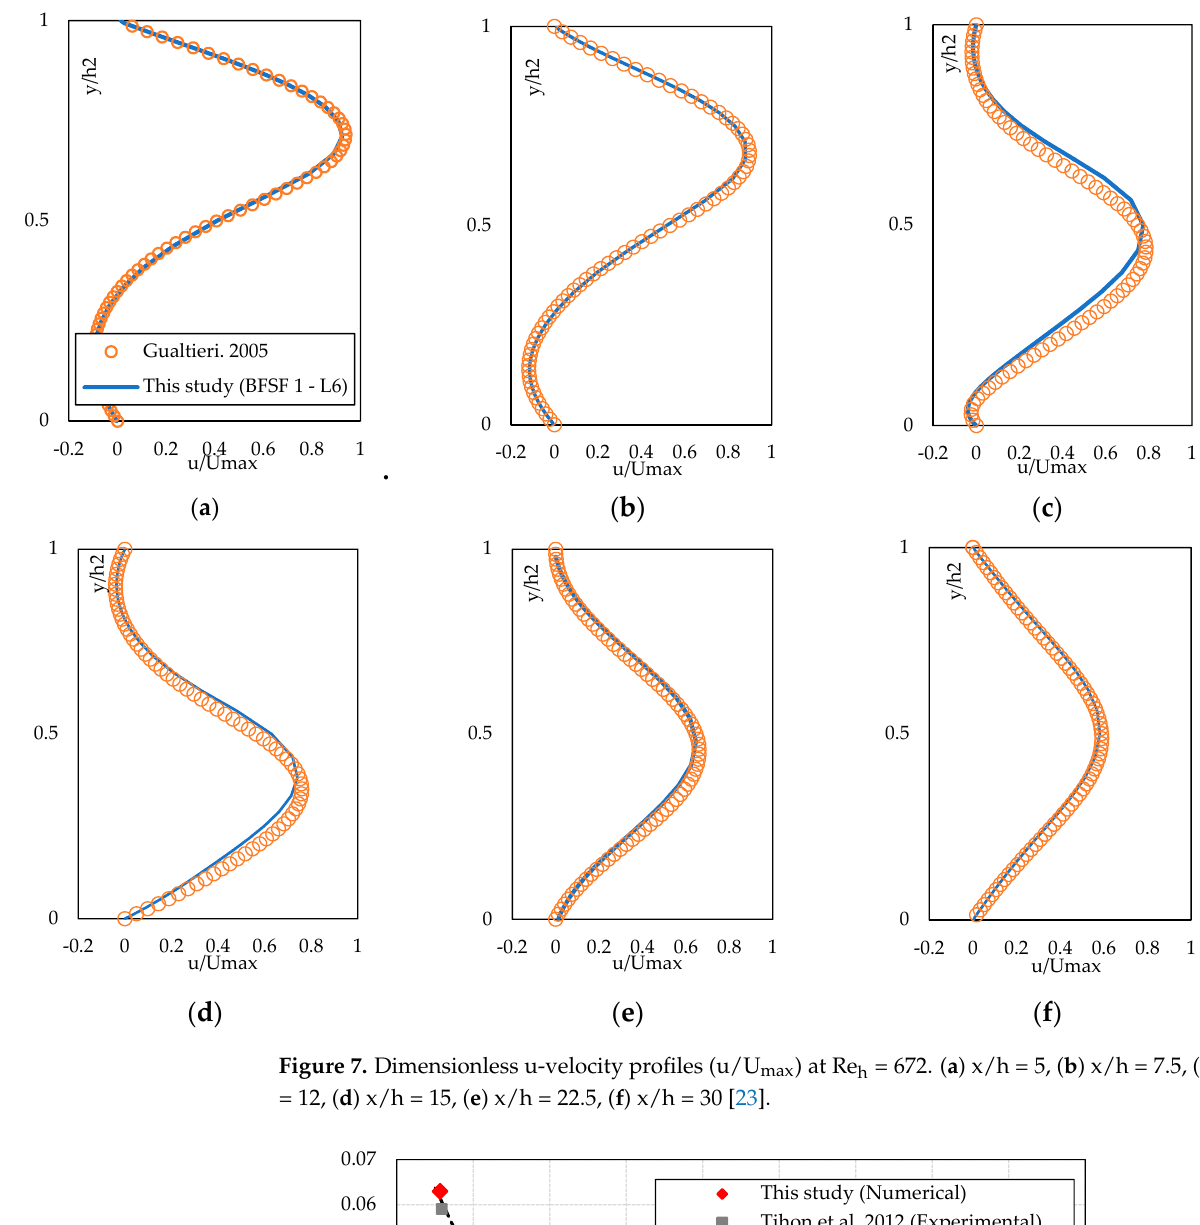
Figure 6. Dimensionless u-velocity profiles (u/U max ) at Re h = 75. ( a ) x/h = 4.8, ( b ) x/h = 12.04, ( c ) x/h = 30.31 [3].